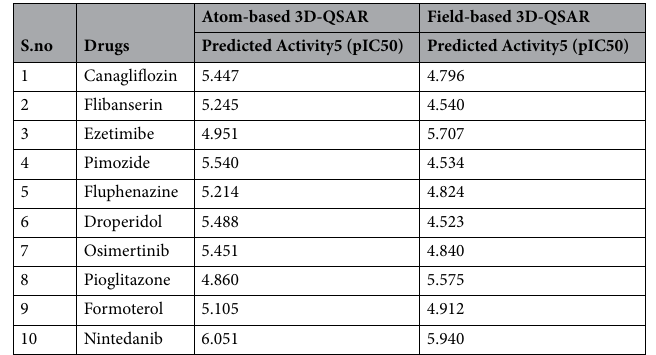
Table 3. Predicted activity values for the selected FDA-approved drugs using developed and validated 3D-QSAR